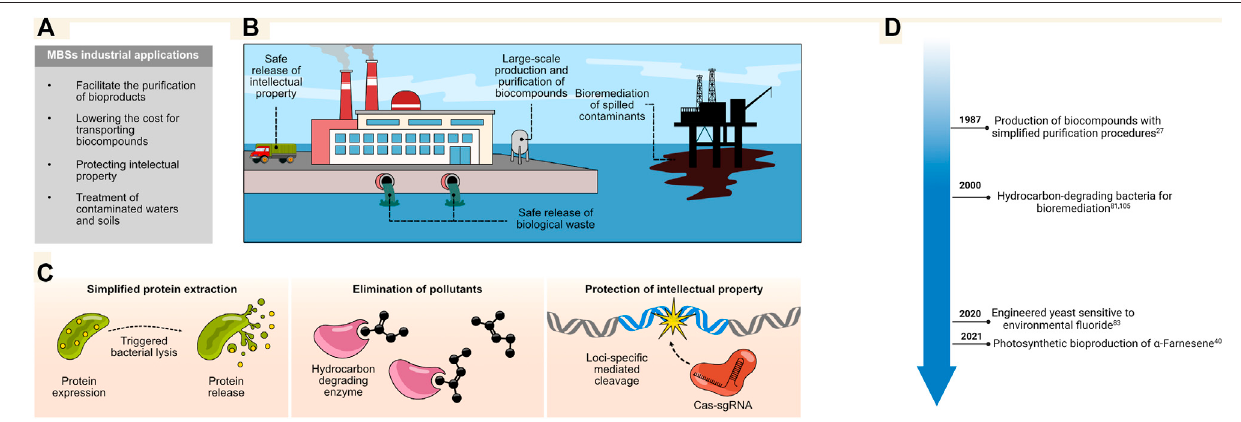
FIGURE 4 | (A,B) MBSs can be used in various industrial processes ranging from the large-scale production of bio-compounds to the protection of sensitive material, the treatment of biological waste, and even the decontamination of accidentally released harmful material. (C) Different strategies have been designed to facilitate the puri fi cation of bio-compounds produced at a large scale; some of these rely on induced autonomous bacterial lysis (left panel). Other efforts are directed at the elimination of toxins released in the environment by integrating enzymes able to degrade complex hydrocarbons into bacteria; biosafety of the introduced geneticcircuitriesarisesfromtheirlossoffunctiononcethecontaminantsaredepleted(middlepanel).Theprotectionofintellectualpropertycanbeachievedbyinducing damageacrossthegenomeofthestrainofinterest(rightpanel).ThiscaneliminateengineeredgeneticregionsoreveninhibittheproliferationoftheMBS. (D) Timelinefor major industrial